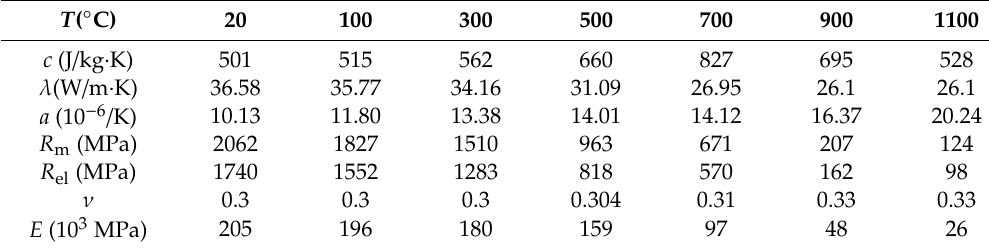
Figure 2. ( a ) Finite element model of the dual frequency induction process and ( b ) experimental set-up. Table 3. Thermo physical